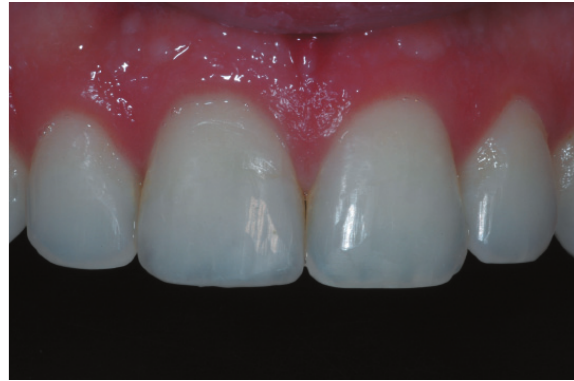
Figure 11- Follow-up at 12